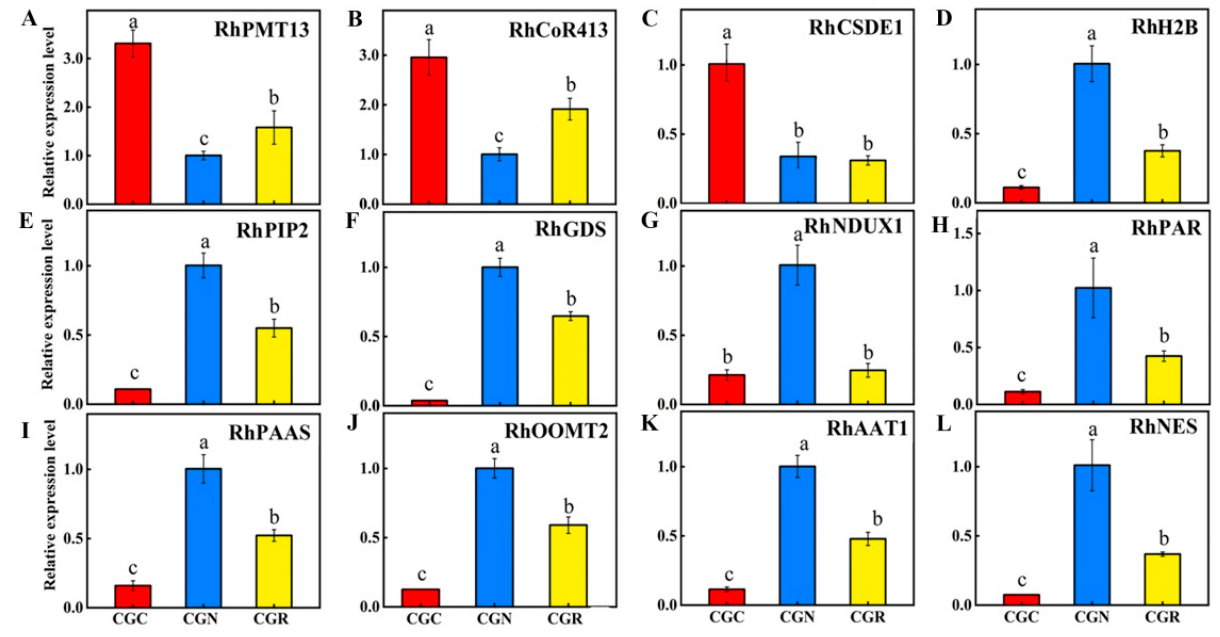
Figure 6. The expression DEGs veri fi ed through RT-qPCR. SE values are indicated by vertical bars (n = 3 replicates). Means with di ff erent le tt ers (a, b, c) are signi fi cantly di ff erent (Tukey’s HSD test, P < 0.05). ( A ) RhPMT13 : Probable methyltransferase PMT13. ( B ) RhCoR413 : Cold-regulated 413 plasma membrane protein 1. ( C ) RhCSDE1 : Cold shock domain-containing protein. ( D ) RhH2B : Probable histone H2B. ( E ) RhPIP2 : Aquaporin PIP2-7. ( F ) RhGDS : Germacrene D synthase. ( G )